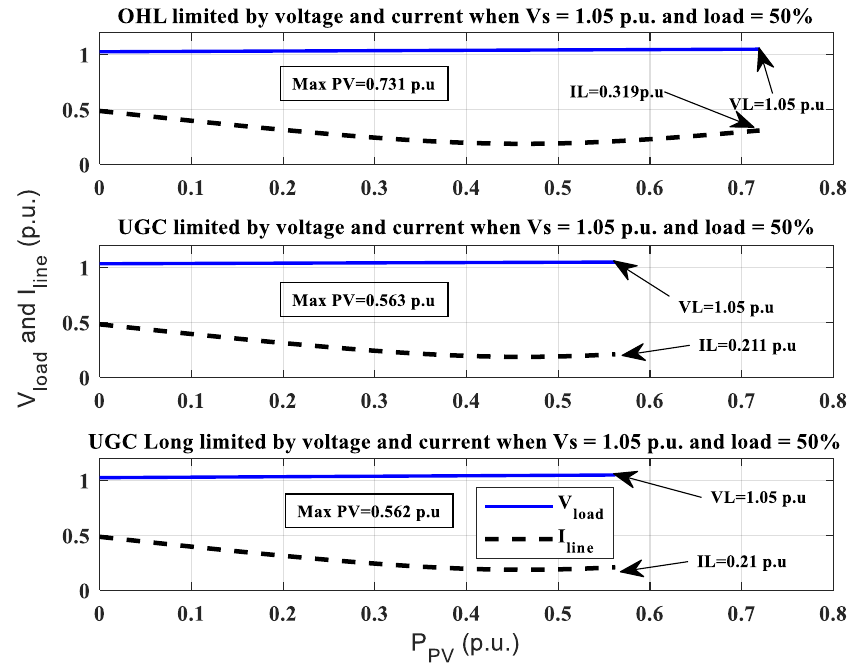
Figure 9. PV maximum penetration limit for substation voltage 𝑉 𝑆 = 1.05 p.u. and load percentage = 50%.